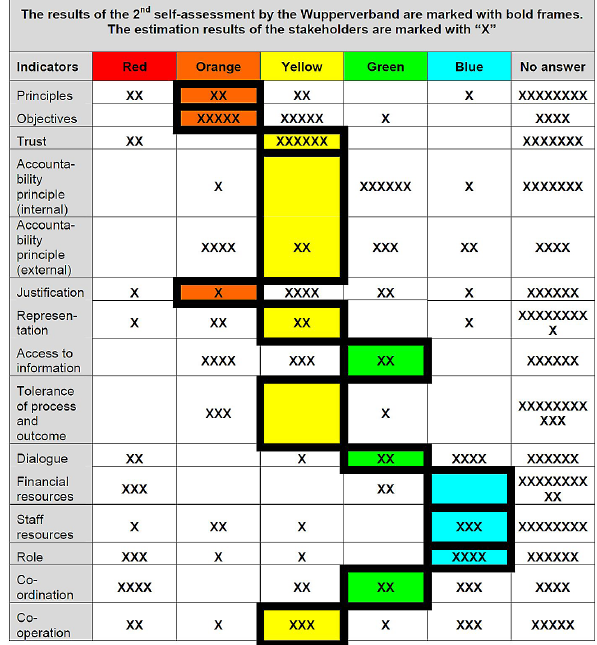
Fig. 2. Self-assessment of the local water authority (Wupperver- band) in the German case study and stakeholders at the end of the project in 2011 (source: Firus et al.,